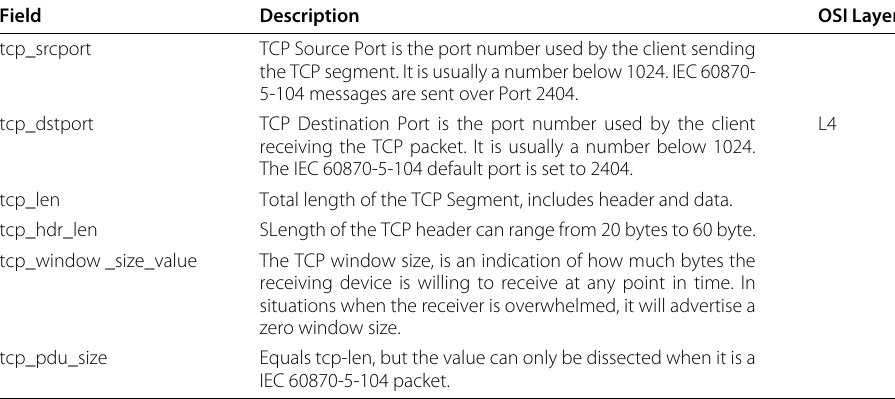
Table 5 Extracted field values from layer